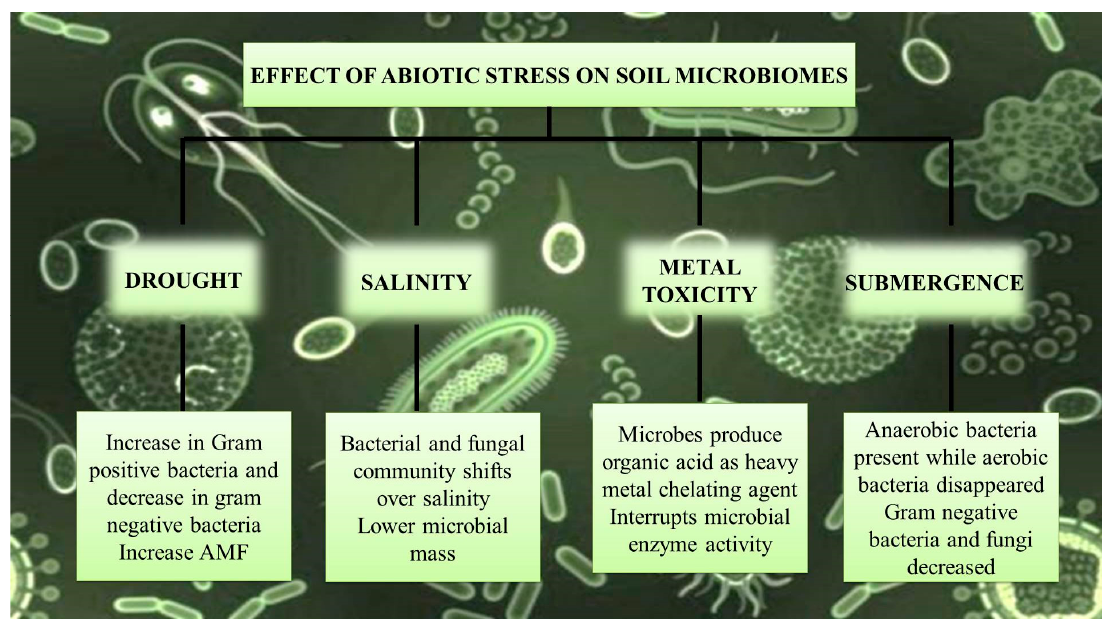
Figure 3. Changes caused by the environmental conditions on soil microbial composition.